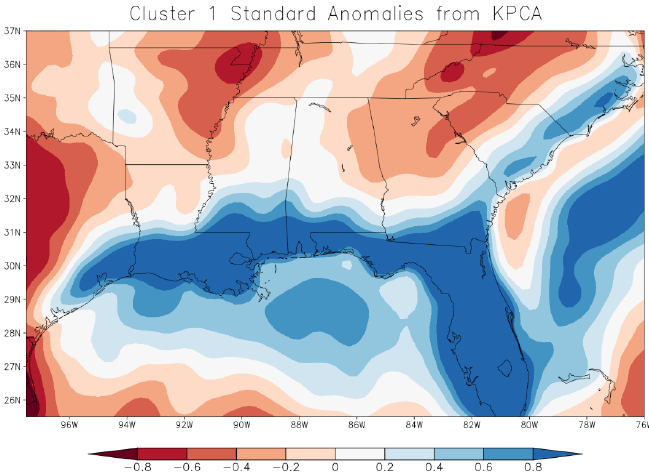
Figure 6. Cluster 1′ s 15-day precipitation standard anomalies derived from KPCA-preprocessed cluster analysis. This pattern closely matched the composite with no KPCA-preprocessing, but 2005 was included as part of this cluster.